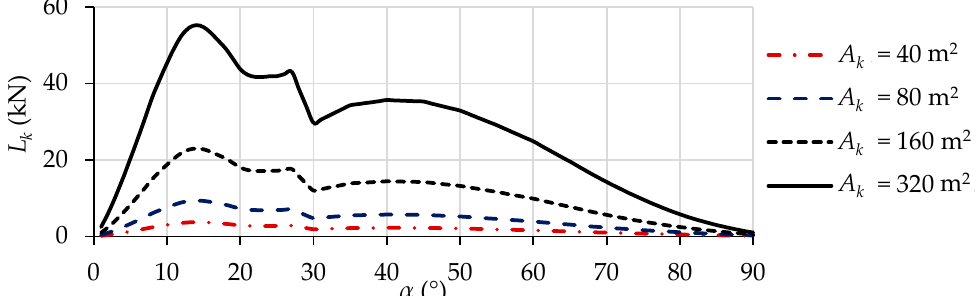
Figure 9. The kite lift forces for each kite area and angle of attack at a ship speed of 7.27 m/s and a reference wind speed of 20 m/s.